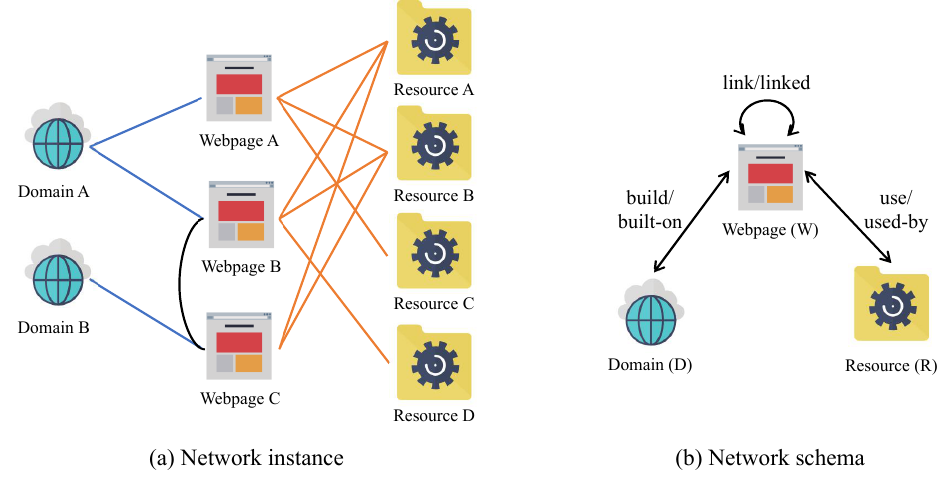
Figure 3. Example of a HIN instance ( a ) and its network schema ( b